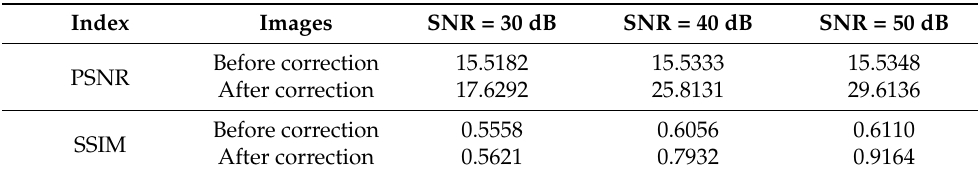
Table 1. Quantitative assessment of simulated data experiments.